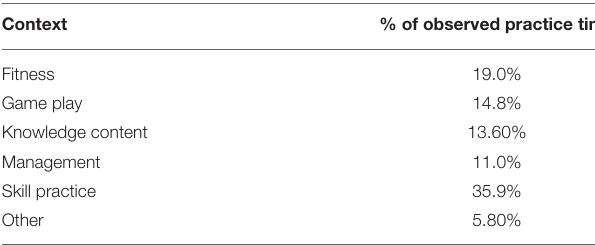
TABLE 4 | Overall percent of time allocated to practice